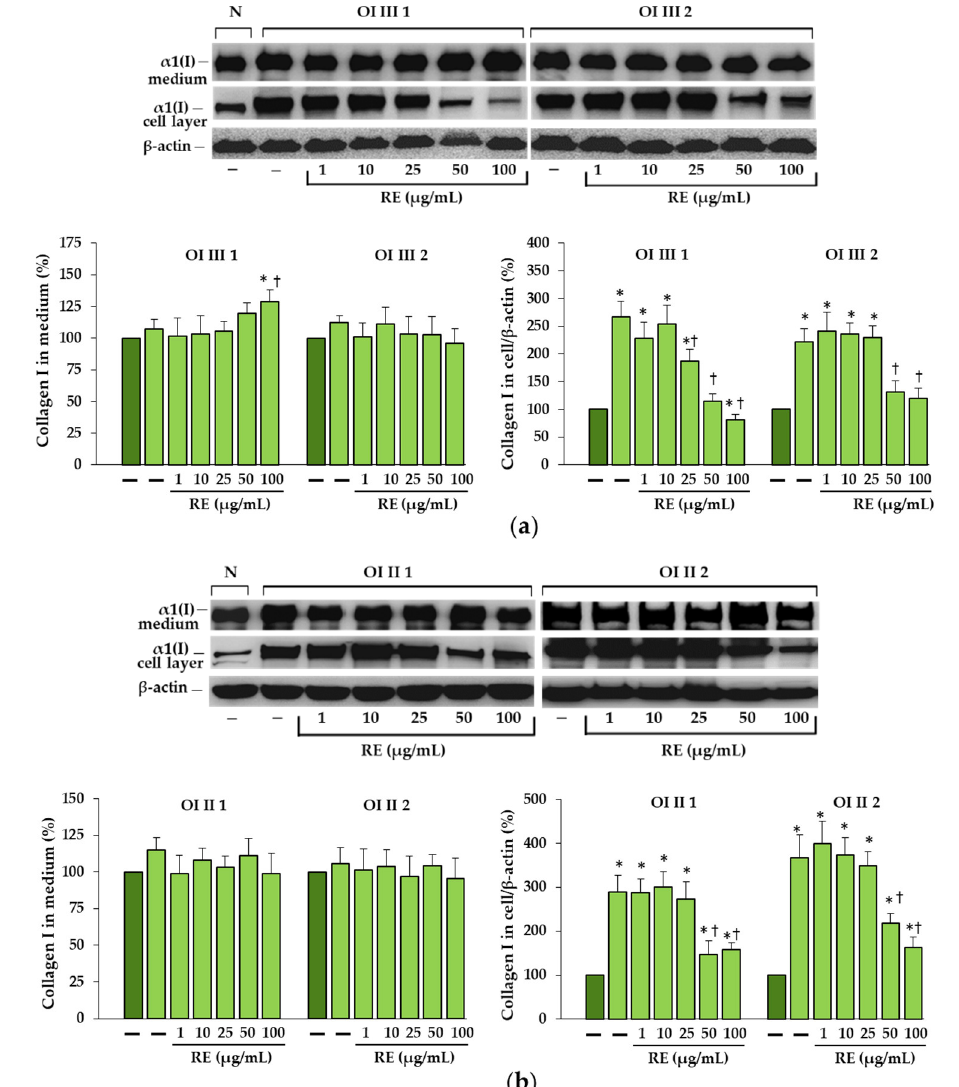
Figure 2. The effect of rosemary extract (RE) on the levels of secreted (in medium) and intracellularly accumulated type I collagen in OI type III ( a ), and OI type II ( b ) cells; β-actin was used as cell protein loading control. The bars represent the results of the gel densitometry as the mean values from three independent experiments; * p < 0.05, OI cells vs. normal (N) cells; † p < 0.05, OI treated cells vs. OI untreated cells. The data are expressed as a percentage of the normal sample taken as 100%; dark green and light green bars represent normal and OI, respectively.